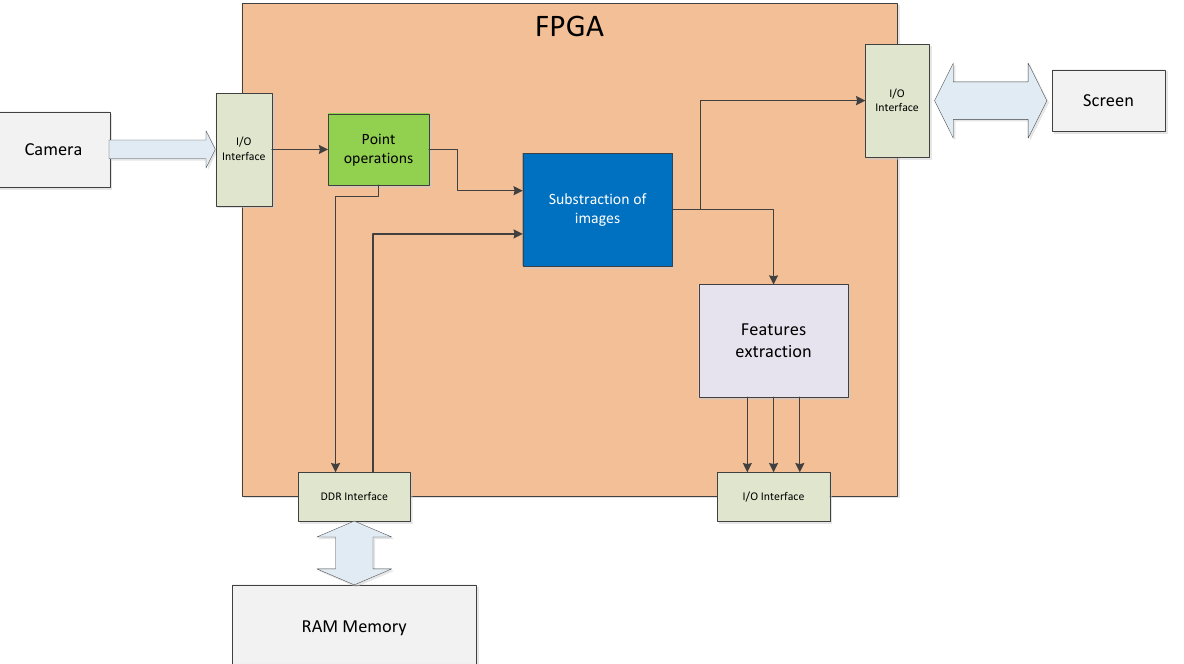
Figure 3. Scheme of a computer vision system embedded on an FPGA. Four points are tracked, and their center of gravity computed at camera frame rate frequency.